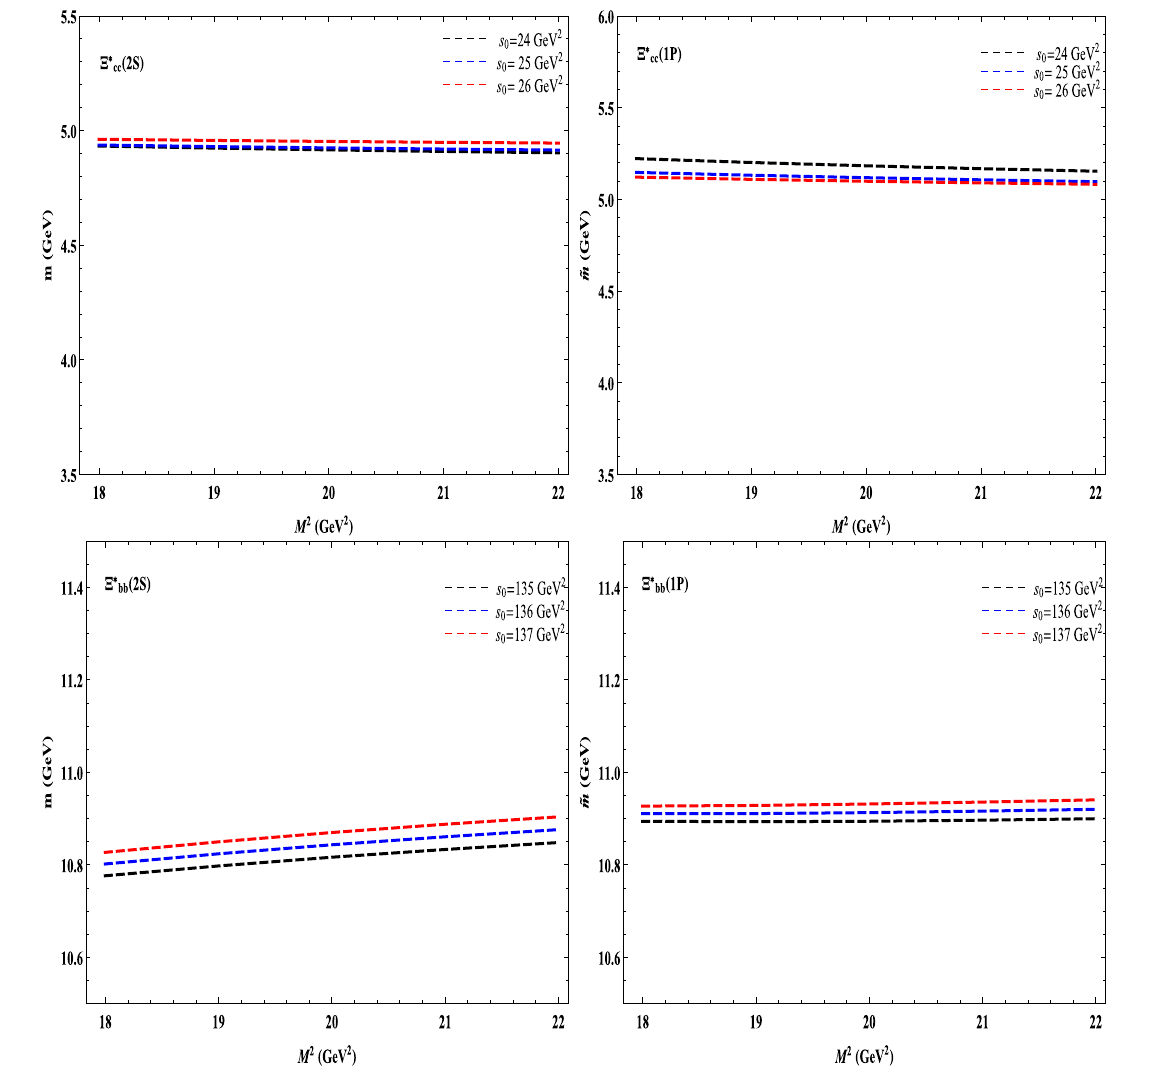
Fig. 2 The dependency of the excited states 2 S , 1 P masses, and pole residues of the doubly-heavy of spin-(3/2) (cid:2) ∗ cc baryon on the Borel mass M 2 at different values of the continuum threshold s